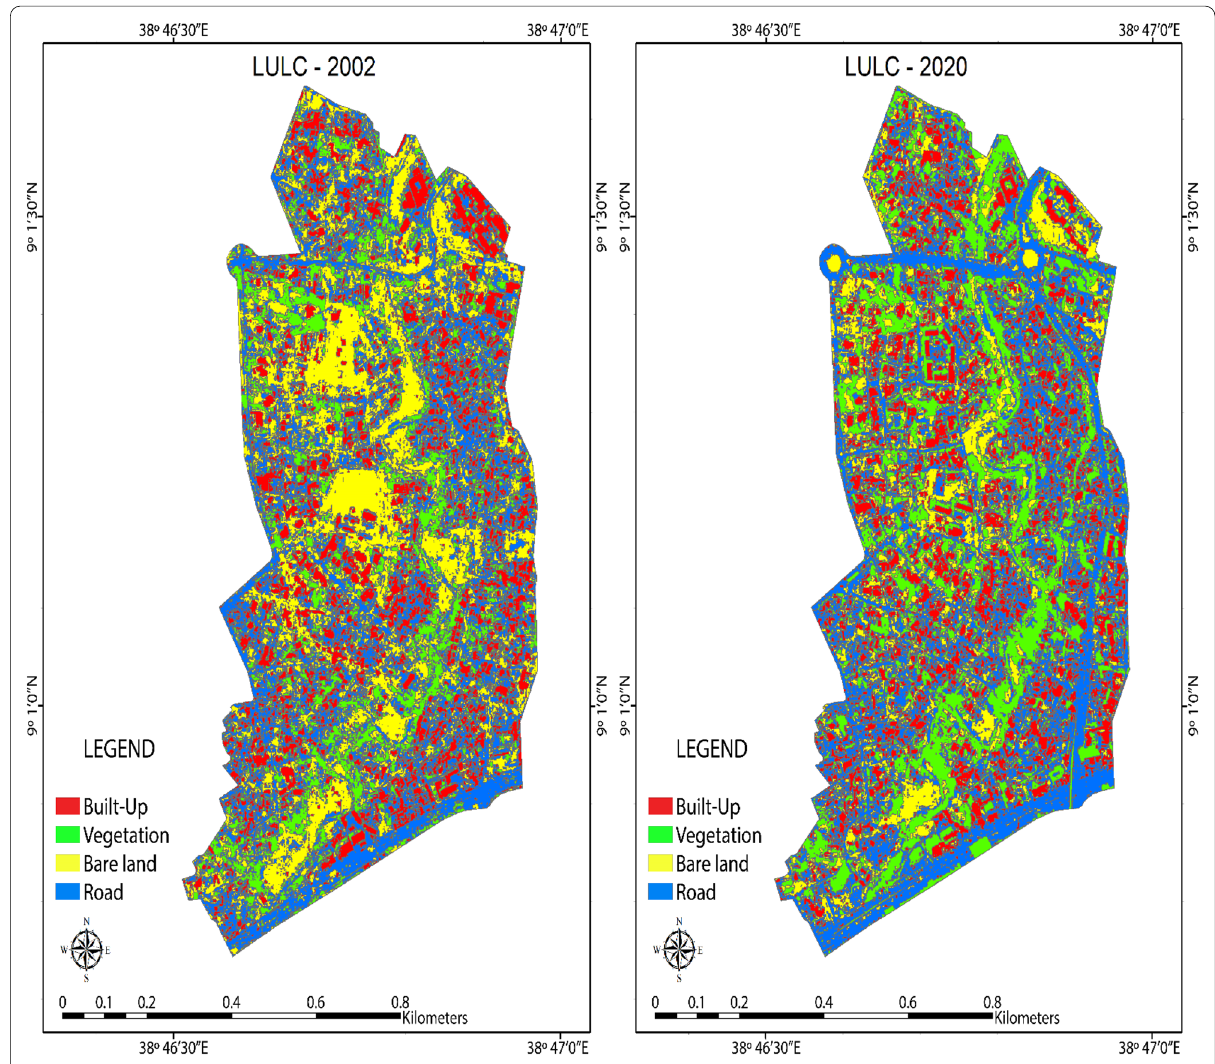
Fig. 9 Land-use and land-cover (LULC) map of the study area in Addis Ababa for the years 2002 and 2020